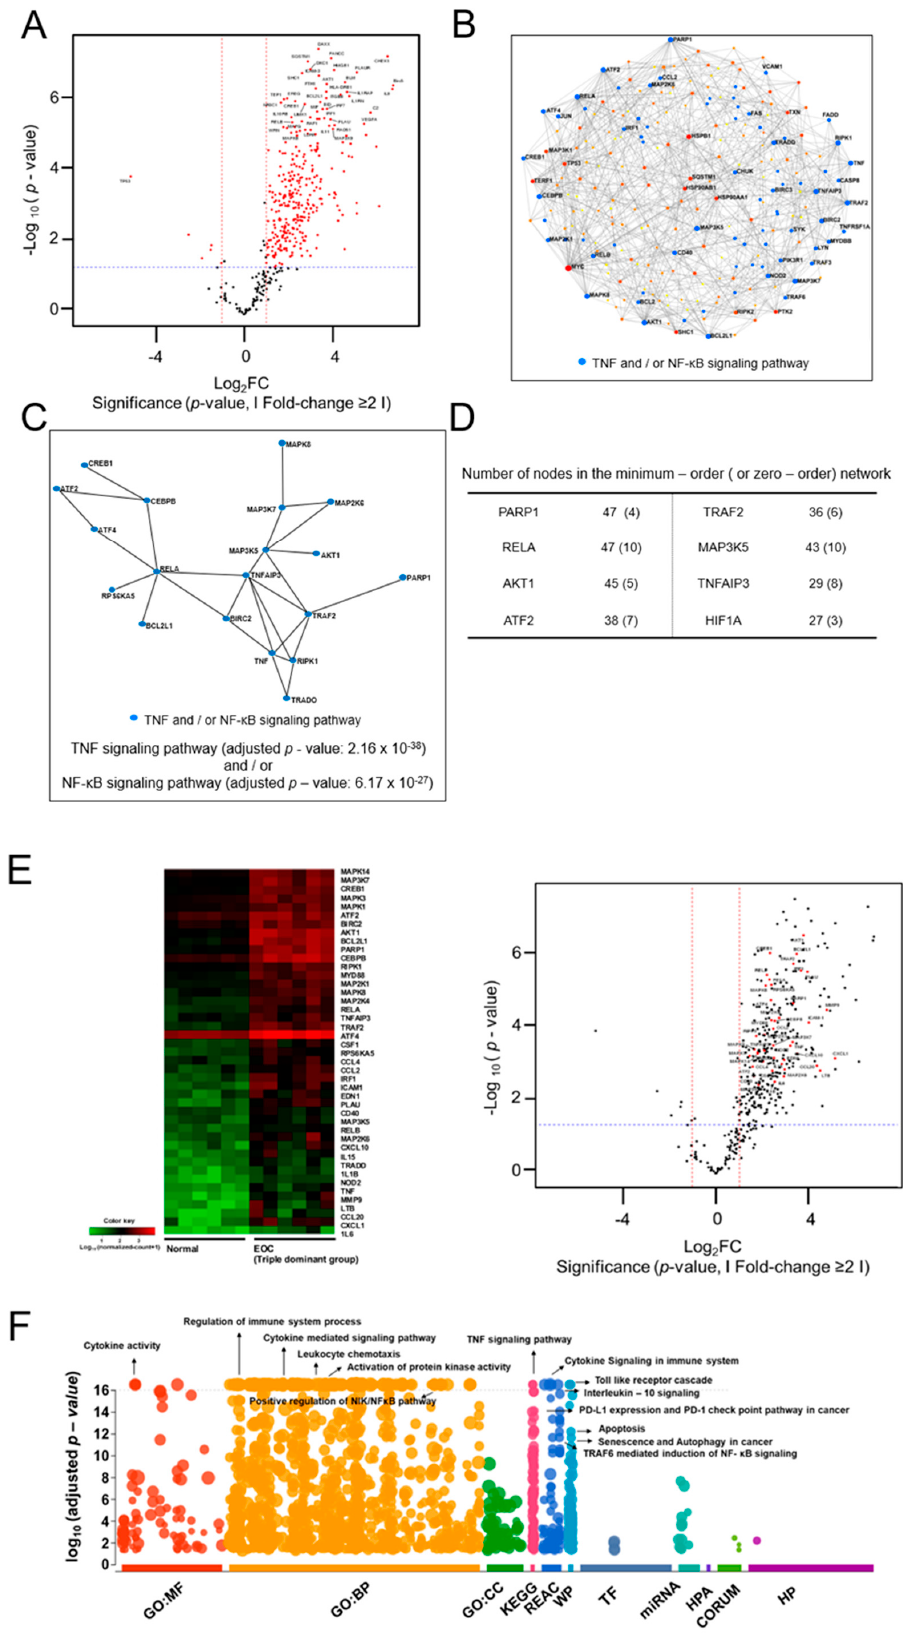
Figure 4. Analysis of differentially expressed genes (DEGs) in the triple dominant EOC group as compared to gene expression in normal ovarian epithelial tissues. Analysis of differentially expressed genes (DEGs) in the triple